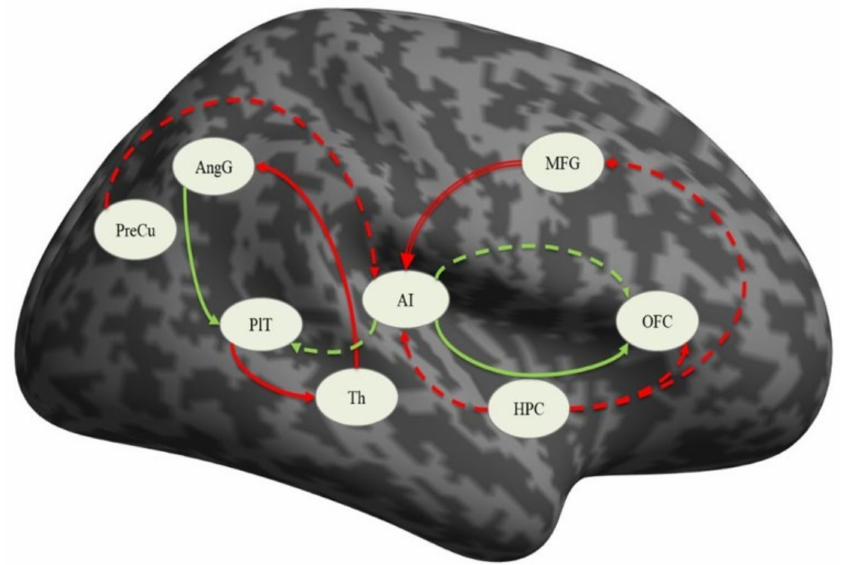
Figure 2. Connections significantly different from zero: solid line—schizophrenia, dashed line— in depression, green—excitatory, red—inhibitory, double red line—significantly different between the groups. PreCu—precuneus, HPC—hippocampus, AI—anterior insula, AngG—angular gyrus, OFC—orbitofrontal cortex, PlT—planum temporale, Th—thalamus, MFG—middle frontal